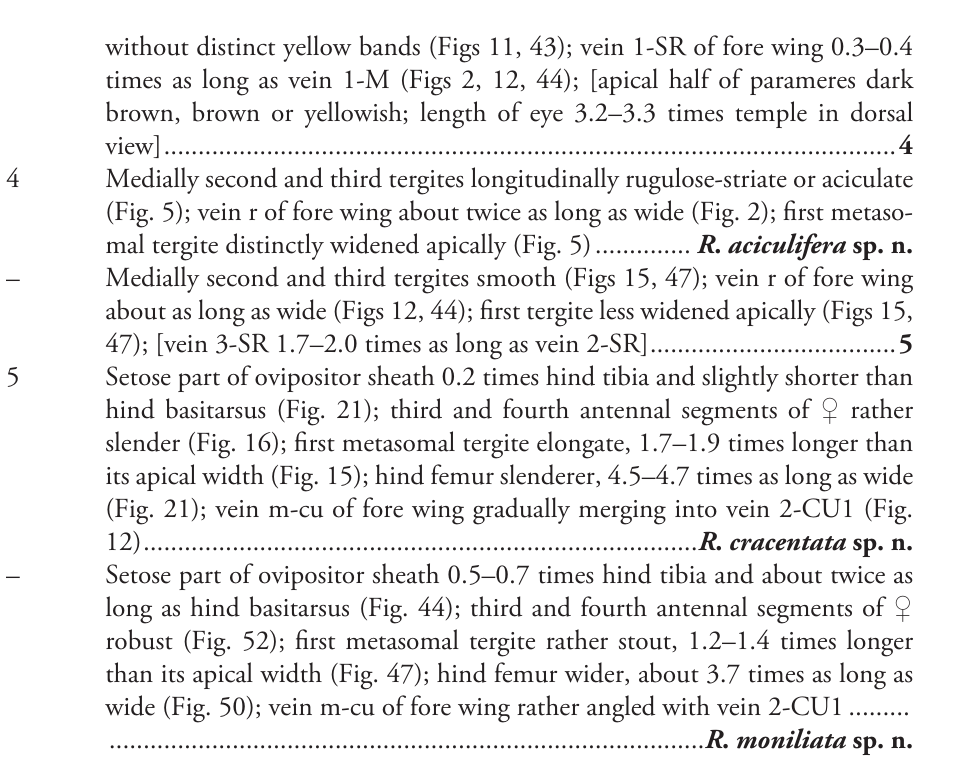
Figs 1–10 Type material. Holotype, ♀ (NWUX), “NW China : Shaanxi , Liping Nat. For. P., MT1+2, c. 1495 m, 22.vi.-4.ix.2015, 32°47'33"N, 106°39'52"E, JL. Tan & C. v. Achterberg”. Diagnosis. Among the Chinese species of Rhogadopsis with the second and